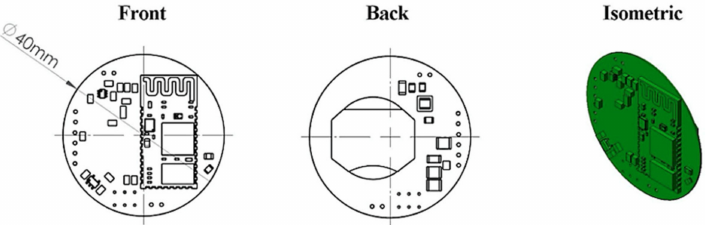
Figure 7. Front, back and isometric views of PCBA with MCU and Bluetooth module. Back view of the designed PCBA shows the introduced placement for coin type battery.